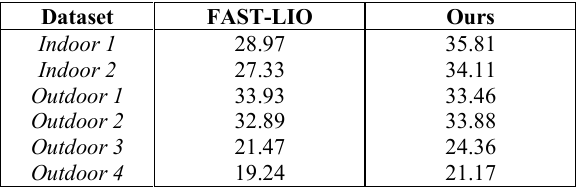
Table 3. Run time per frame ( ms